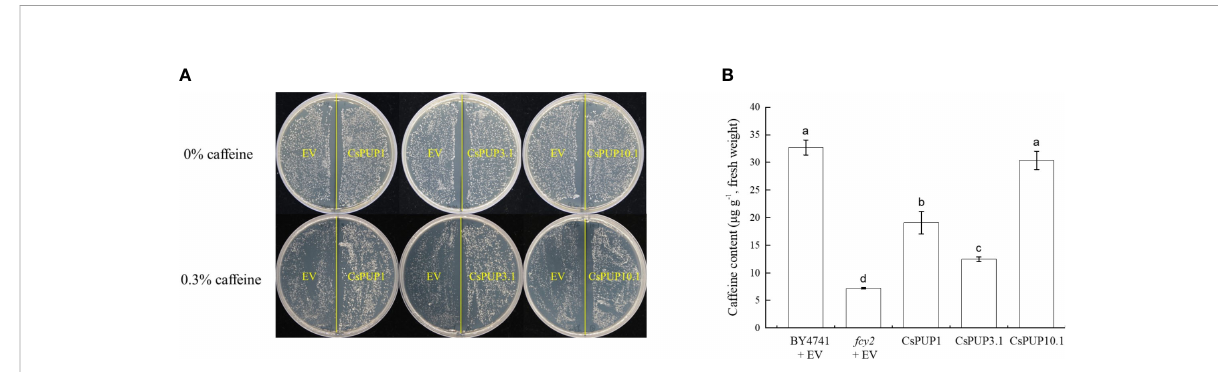
FIGURE 8 Functional identi fi cation of CsPUP1, CsPUP3.1 and CsPUP10.1 in yeast. (A) Phenotypic differences of yeast growth; (B) Caffeine accumulation in different yeast cells under 0.3% caffeine treatment.